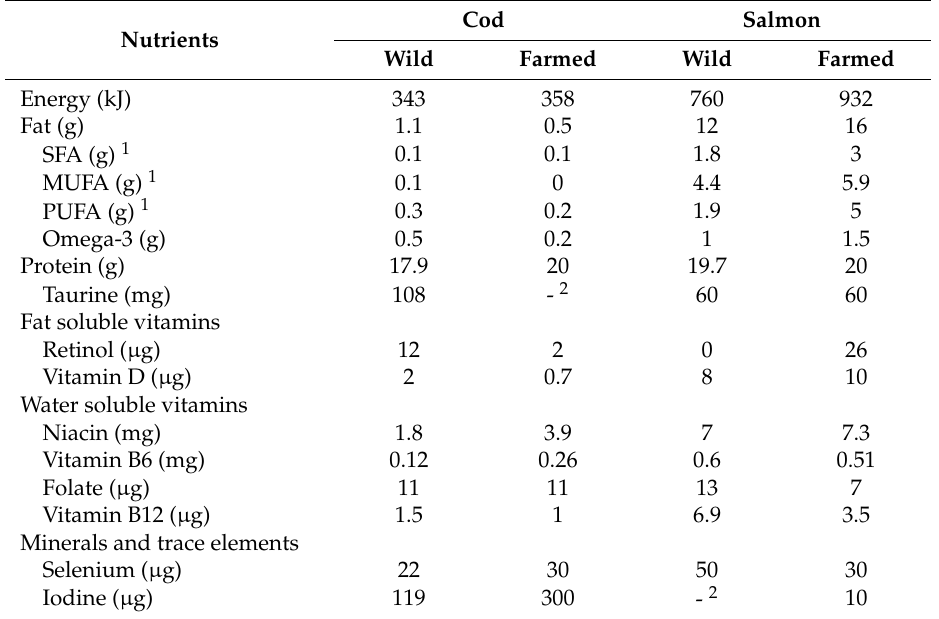
Table 1. Nutritional profile of commonly consumed, whole, raw fish, per 100 g [27,28]. Cod Nutrients